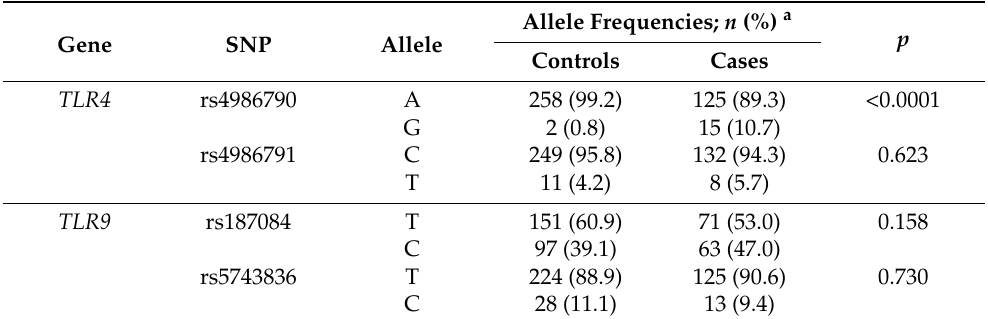
Figure 2. Genotype frequencies of the TLR4 rs4986790 SNP in patients with ovarian cancer (cases) and healthy women (controls). p -values were calculated using Fisher’s exact test. Table 2. The distribution of the allele frequencies of TLR SNPs in healthy women and women with ovarian cancer.